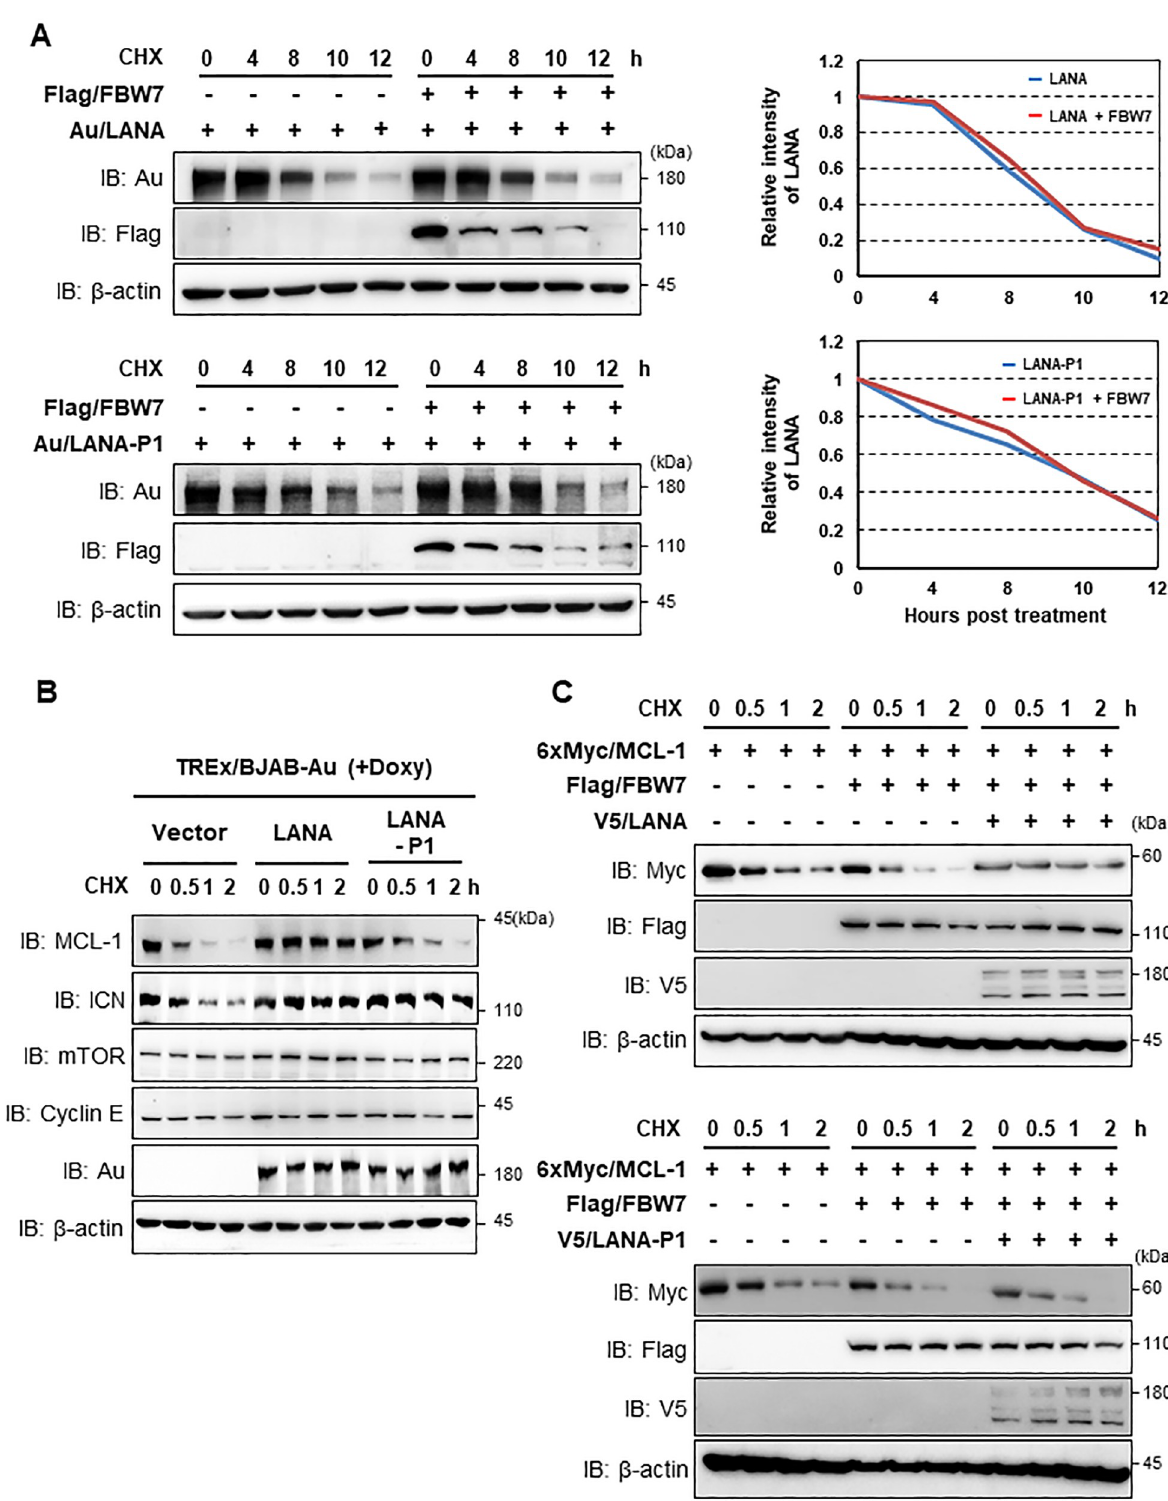
Fig 2. The LANA-FBW7 interaction specifically stabilizes the MCL-1 protein. (A, upper left) After transfection with LANA-WT and/or FBW7, cells were treated with cycloheximide (CHX, 20 μ g/ml) for the indicated periods, followed by IB with anti-Au, anti-Flag, or anti- β -actin antibodies. (A, bottom left) At 40 h post-transfection with LANA-P1 and/or FBW7, 293T cells were treated with CHX (20 μ g/ml) for the indicated